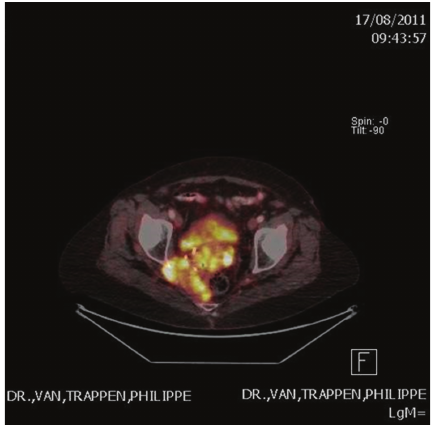
Figure 3: PET-CT visualizing FDG accumulation in the extranodal tumor located in the pelvis with tumor extension into the sacrum and the gluteal/obturator muscle on the right